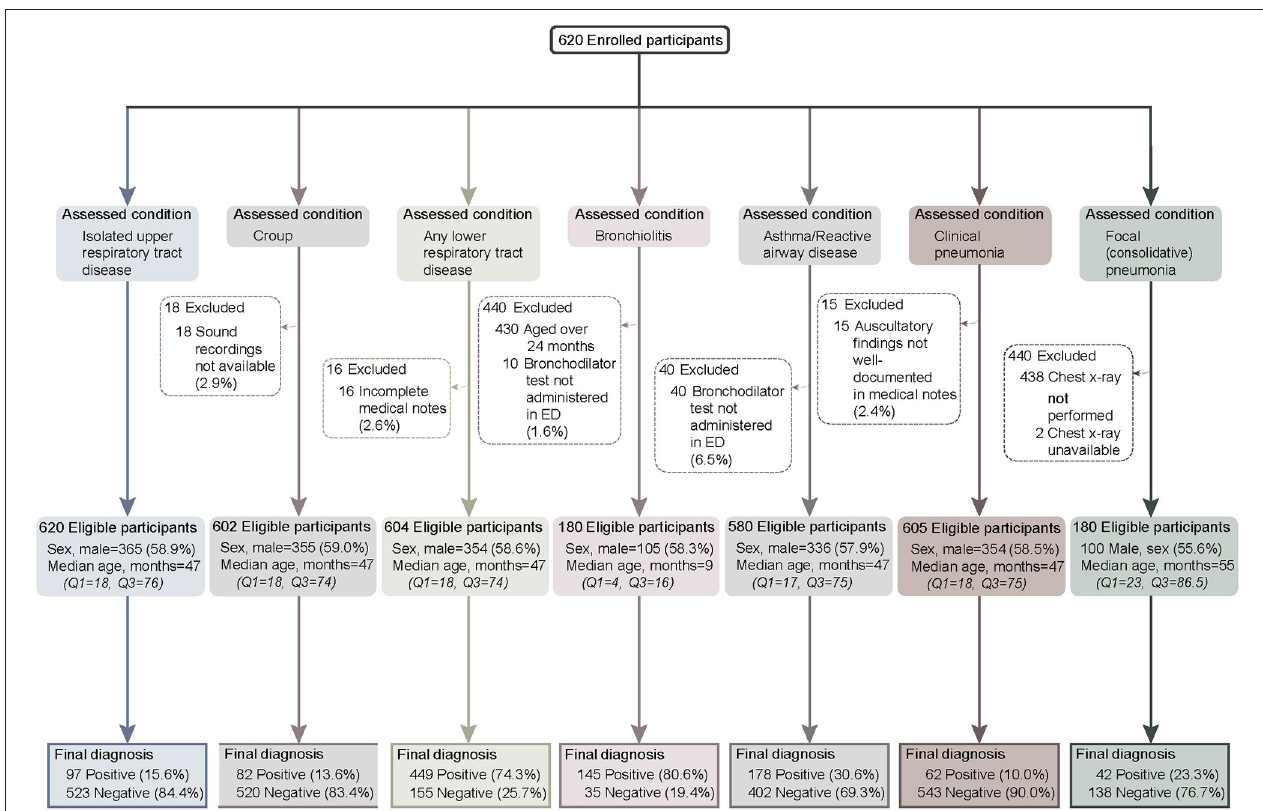
FIGURE 1 | Participant demographics and flow through the study by individual study